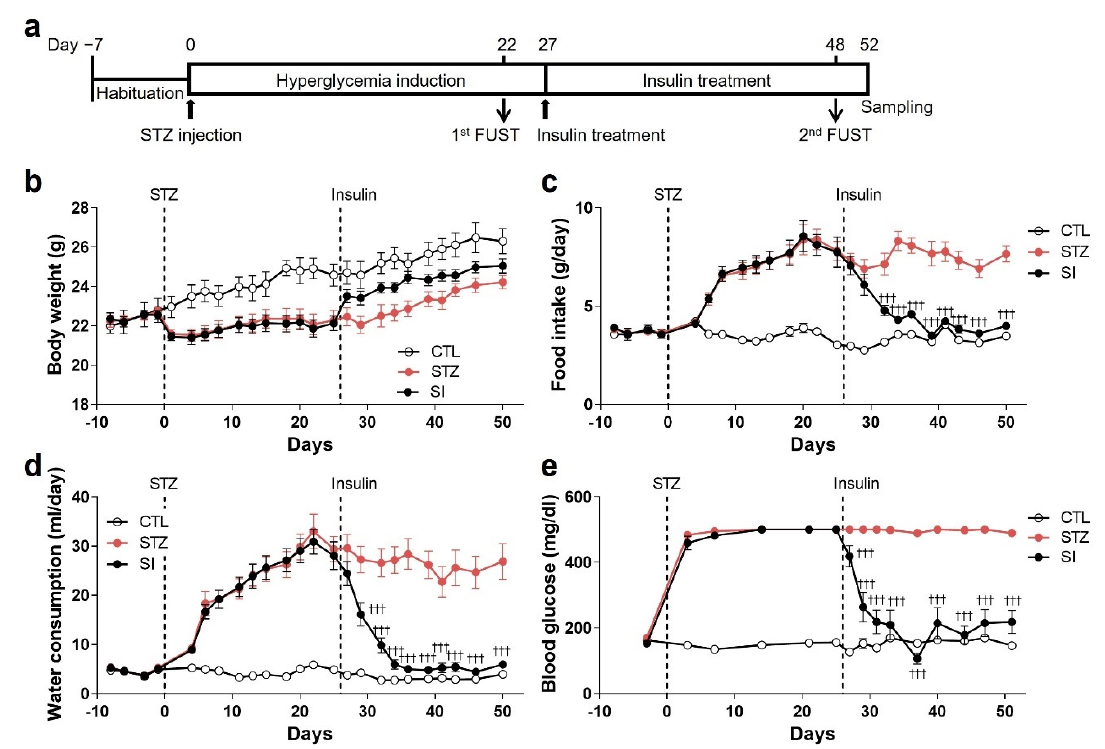
Figure 6. Insulin treatment reversed hyperglycemic phenotypes. ( a ) Experimental design to investigate the effects of insulin on hyperglycemia-induced alterations. After 4 weeks of hyperglycemia induction, insulin pellets were implanted and maintained for 4 weeks. ( b – e ) Changes in body weight ( b ), food intake ( c ), water consumption ( d ), and blood glucose levels ( e ). CTL, n = 7; STZ, n = 7; SI, insulin-treated STZ group, n = 11. Data are presented as mean ± SEM. ††† p < 0.001 compared with the STZ group according to two-way ANOVA with Tukey’s post-hoc tests.